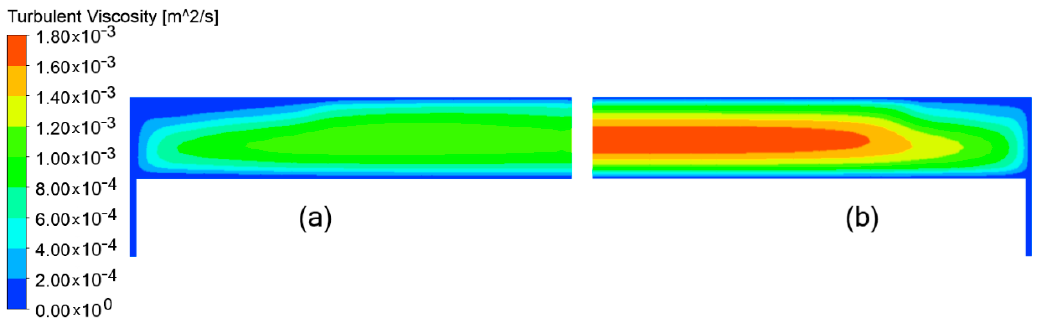
Figure 12. Turbulent diffusivity distribution at 15 CAD BTDC in the case with a flat piston: ( a ) with swirl; ( b ) without swirl.